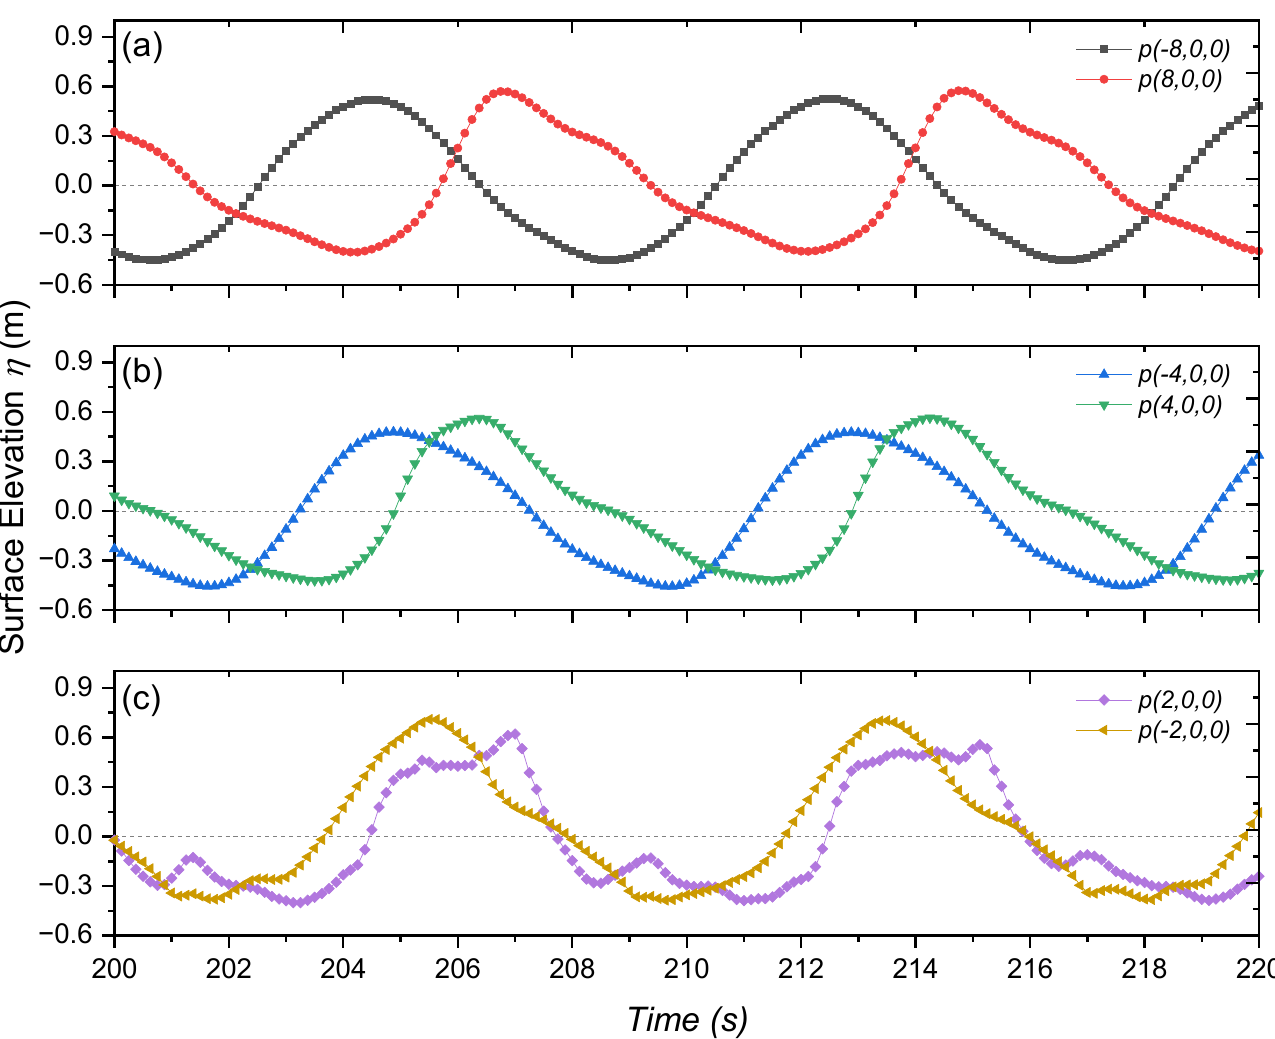
Figure 10. Surface elevation records for the test with H = 1.0 m, T = 8 s, and R = 0.25 m for virtual gauges at symmetrical distances from the buoy: ( a ) 2, ( b ) 4, and ( c ) 8 m to each side. Negative values to the left of the buoy and positive to the right.